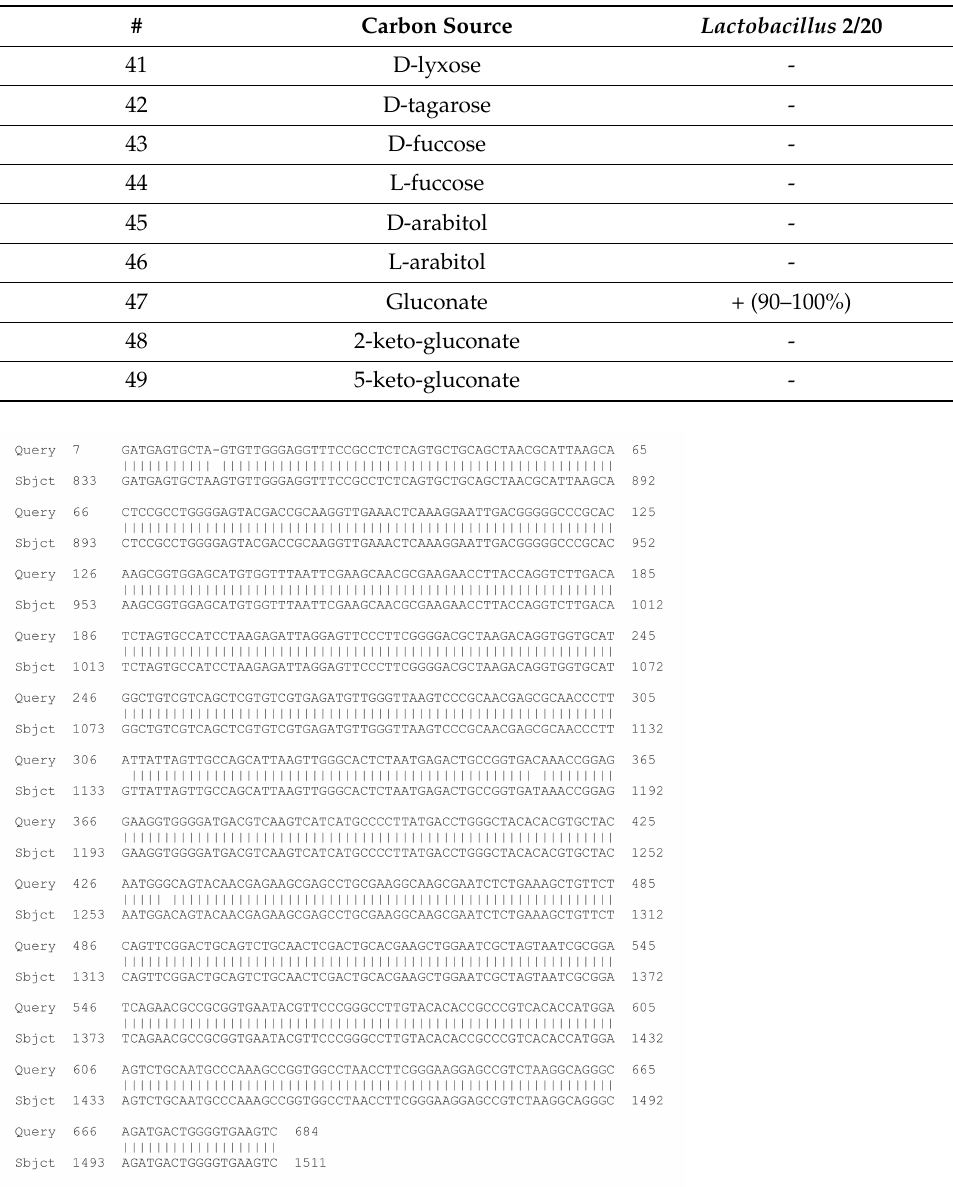
Figure 1. Comparison between the partial nucleotide sequence of the 16S rDNA of Lactobacillus 2/20 and the partial nucleotide sequence of the 16S rDNA of Lactobacillus helvetucus DSM 20075. 3.2. Biopreservation of Chocolate Mousse: Determination of the Survival of Lactobacilli and Pathogenic Bacteria during Storage at Temperatures of 4 ± 2 ◦ C and 20 ± 2 ◦